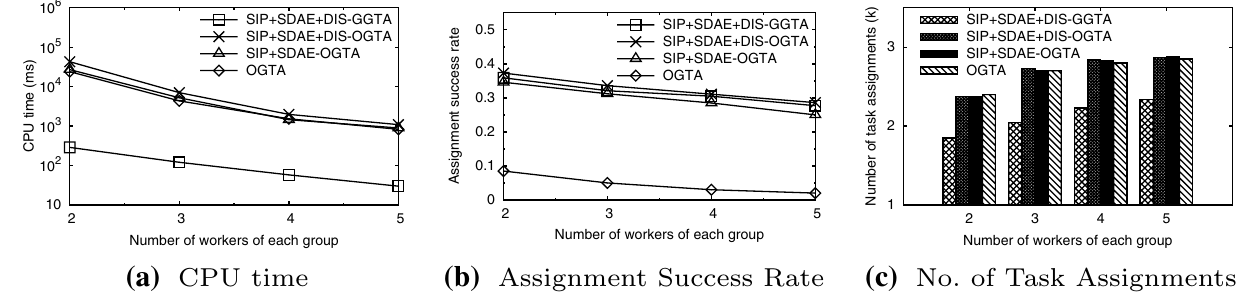
Fig. 12 Performance of group task assignment: effect of numW